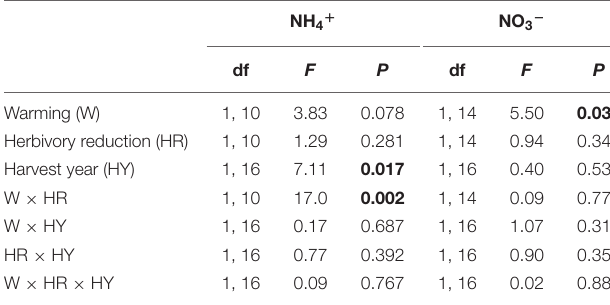
TABLE 5 | F and P statistics of the effects of warming (ambient, +3 ◦ C) and herbivory reduction (normal, reduced) on the quantity of NH 4 + and NO 3 − captured by resin capsules placed under field layer vegetation and harvested after one and two growing seasons (block was included in the models as a random factor and the initial soil NH 4 + and NO 3 − concentrations as covariates, but these effects are not reported; P < 0.05 are in